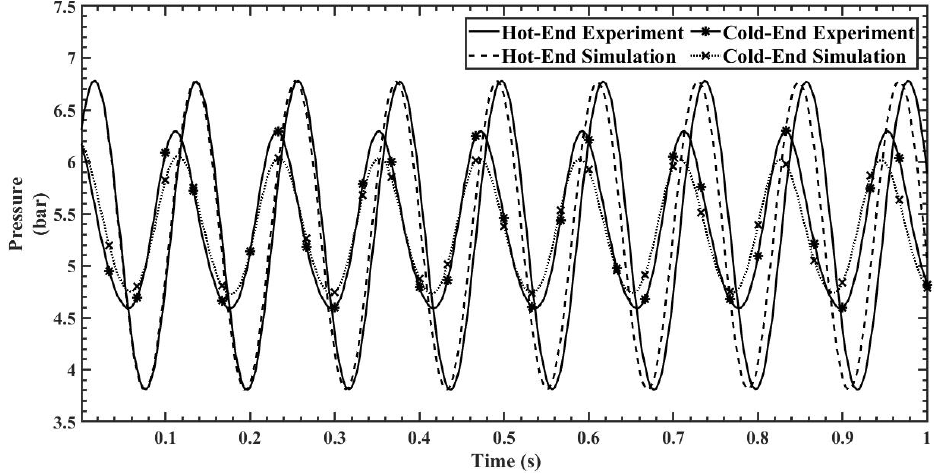
Figure 17. Hot- and cold-section pressure characteristics of a 200 mesh regenerator at 500 RPM.